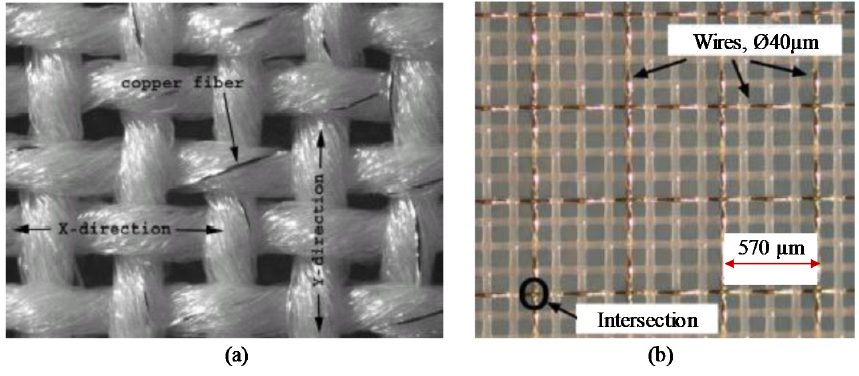
Figure 12. ( a ) Standard design of copper yarn twisted with polyester fibres; ( b ) PETEX (adapted from [89]).